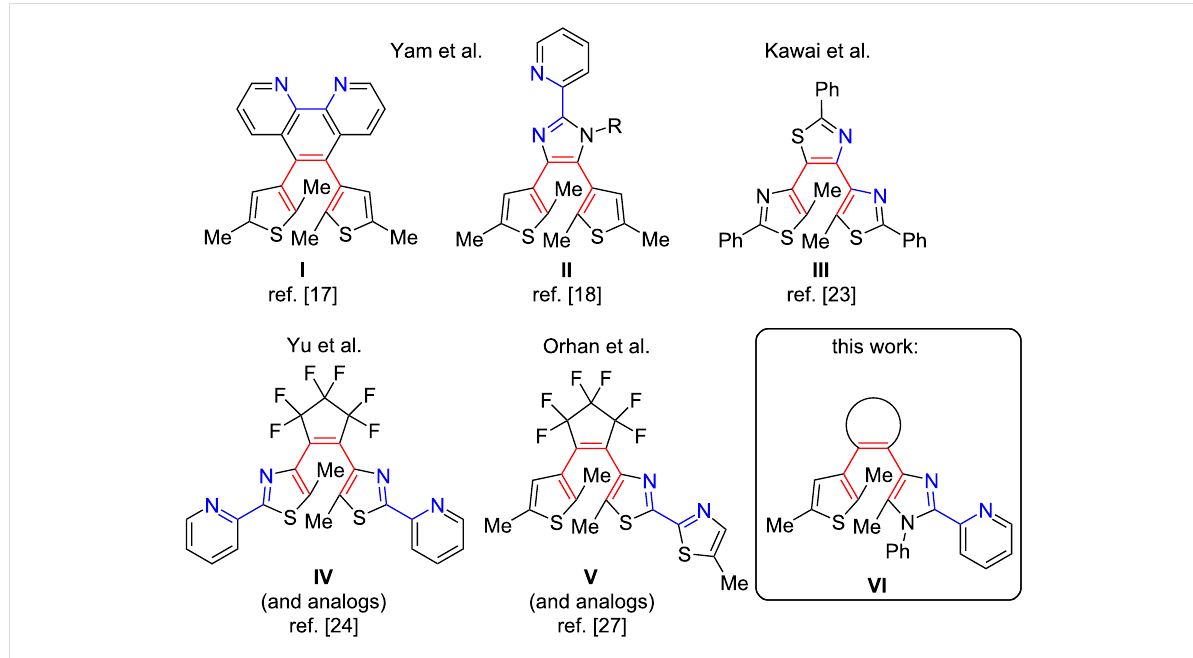
Figure 1: Families of diarylethene-bases ligands with spatial proximity of coordination site (blue) and photoactive framework (red).